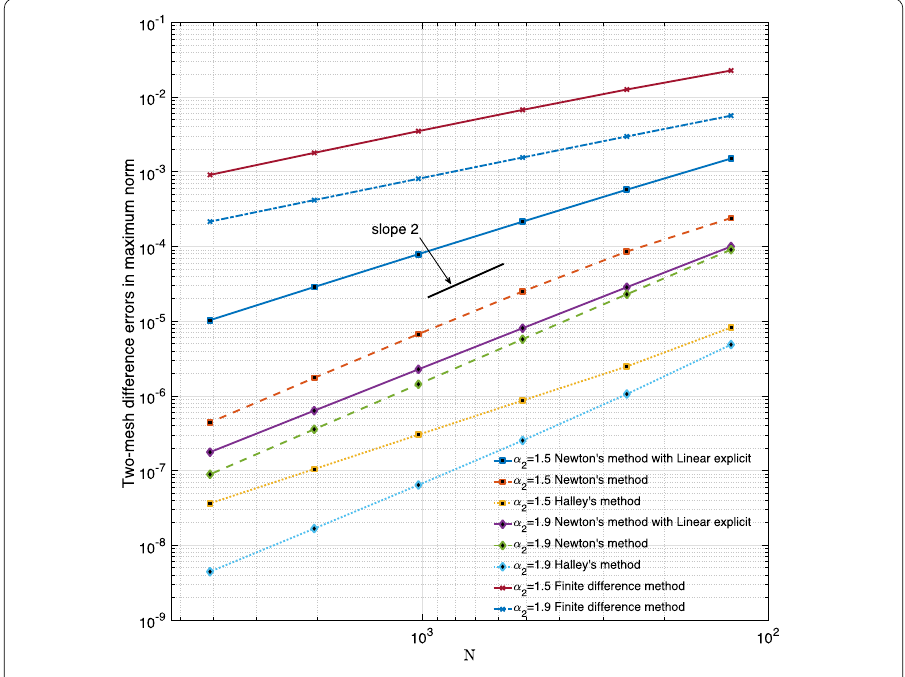
Figure 10 Two-mesh difference errors in maximum norm obtained by the proposed methods and a finite difference [22] of Example 4.6 versus the number of step N when ( α 1 , α 2 ) = (1 – 10 –16 ,1.5),(1 – 10 –16 ,1.9) s 0 = 0.2, Tol = 10